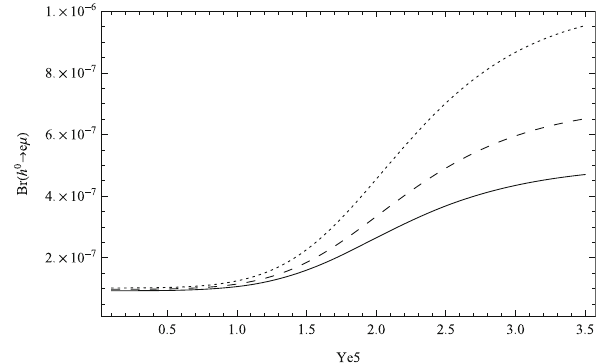
= 1 . 1 ( 1 . 4 , 1 . 7 ) TeV, the branching ratios of h 0 → Fig. 21 With M ˜ E e μ versus parameter Y e 5 are plotted by the dotted, dashed and solid lines